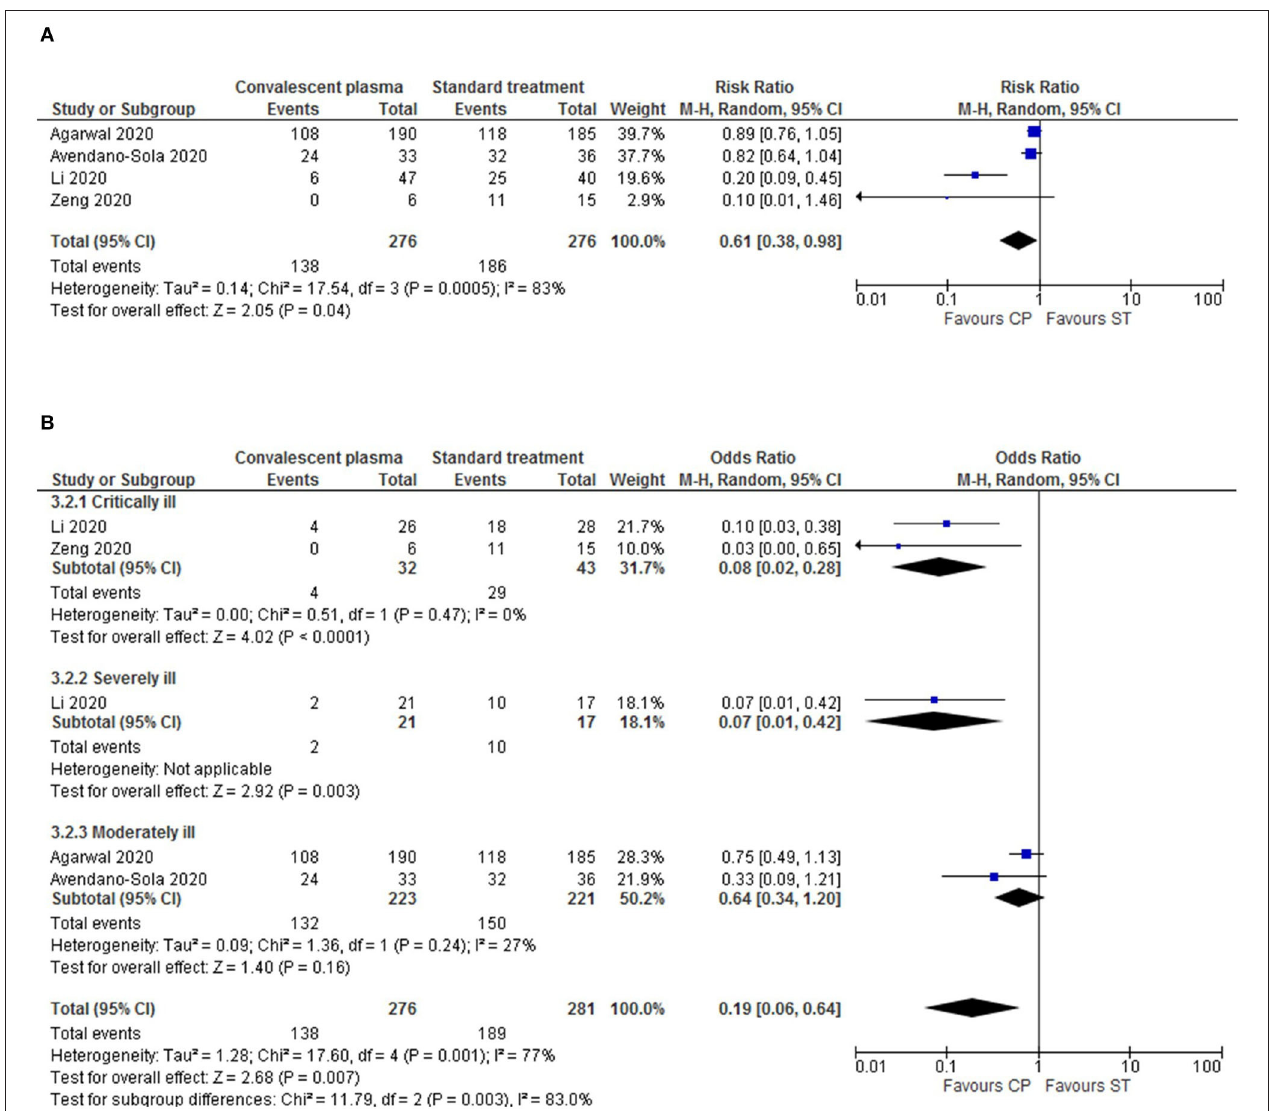
FIGURE 3 | Forest plots depicting viral clearance at 72h after CP transfusion, and respective sub-analysis. (A) At 72h after CP administration, the results showed a significantly reduced number of positive laboratory-confirmed SARS-CoV-2 infection in the CP intervention group. Nevertheless, the overall heterogeneity levels are high; therefore, we conducted a sub-analysis. (B) Sub-analysis by disease severity (Critical, Severe, and Moderate clinical status). Different sizes of data markers correspond to the relative weight assigned in the pooled analysis. Diamond marker indicates the overall result.